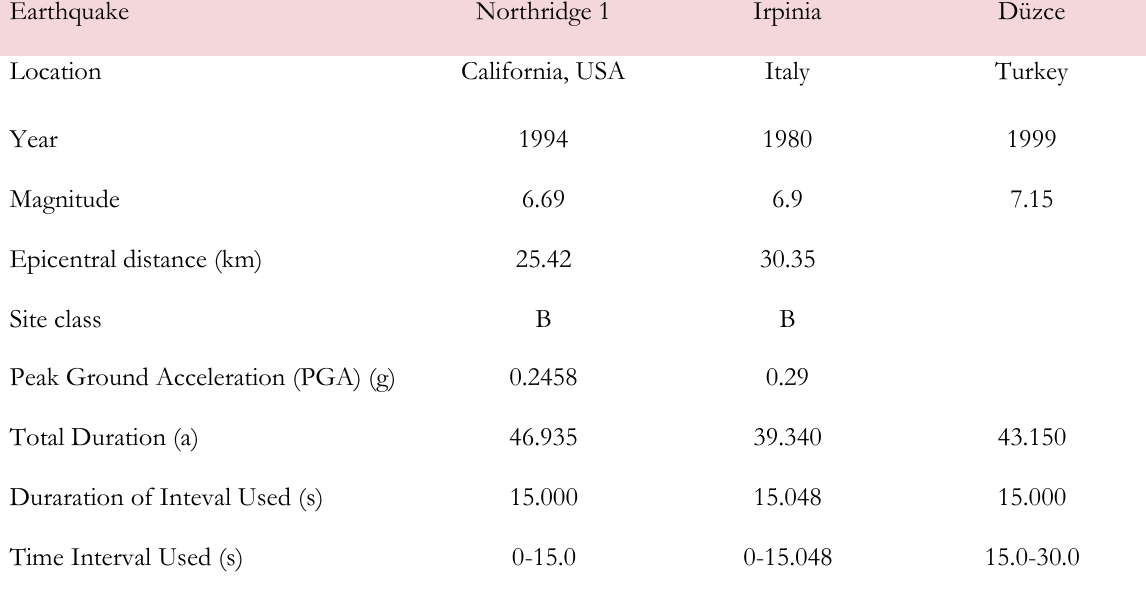
Table 3: Earthquake